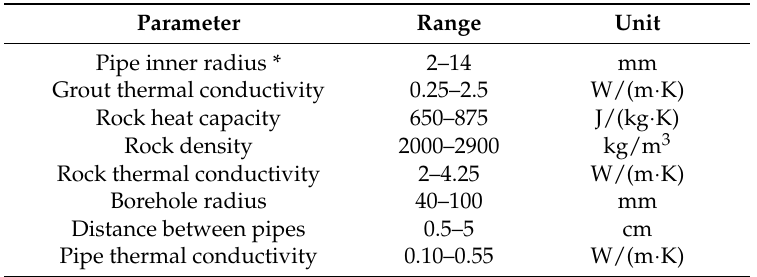
Table 2. The range of the input parameters for the parametric study of the HTiP